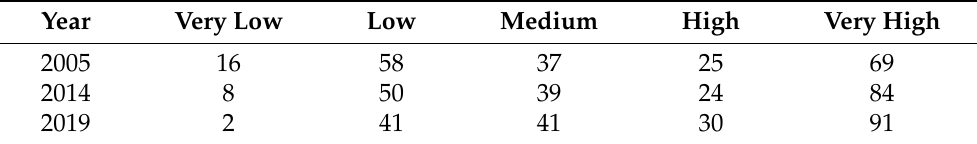
Table A8. Number of subdistricts at each heat wave risk level.